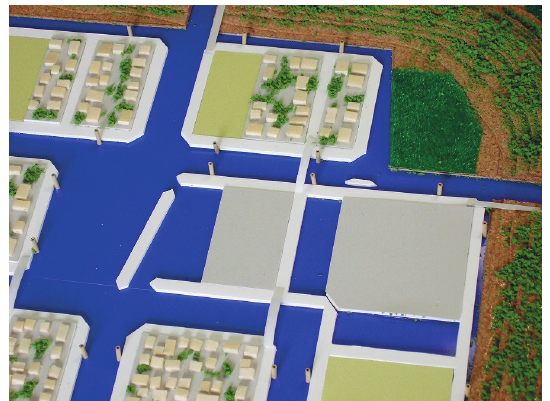
Figure 11. Bird’s-eye view of the floating roads with floater (Image as represented by architectural model).